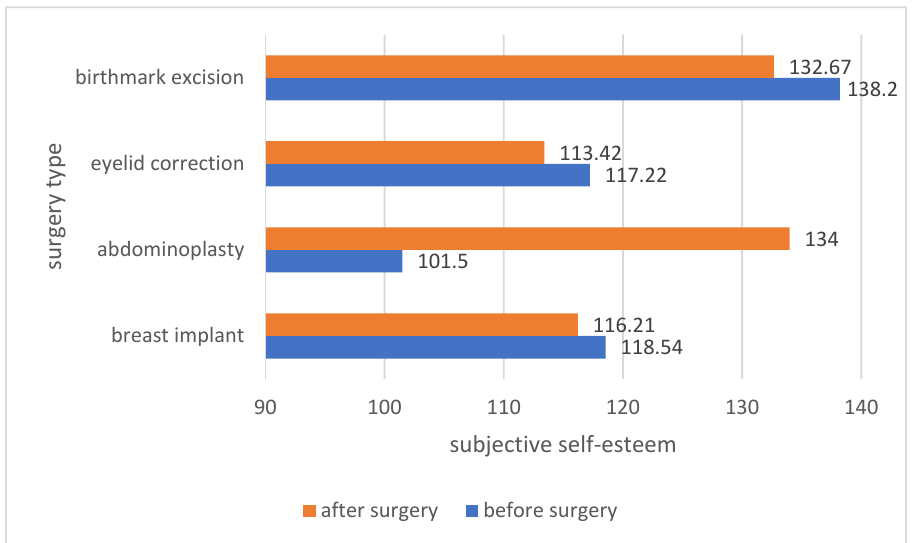
Figure 9. Positive and negative emotions felt among patients before and after the procedure.